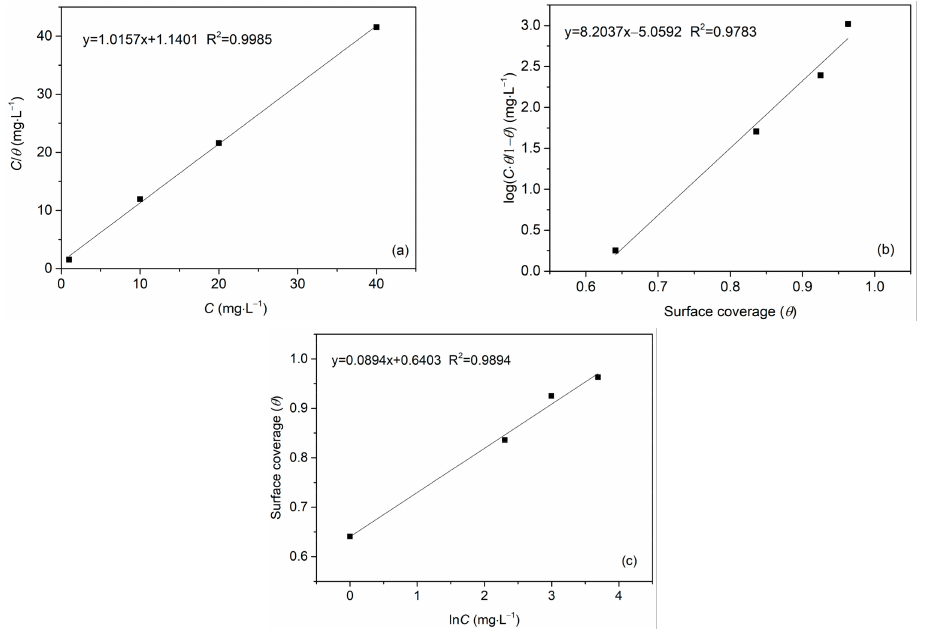
Figure 6. Different adsorption isotherm plots for the adsorption of TSCA on the surface of carbon steel in 1 M HCl at 298 K from EIS results: ( a ) Langmuir’s isotherm, ( b ) Frumkin’s isotherm, ( c ) Temkin’s